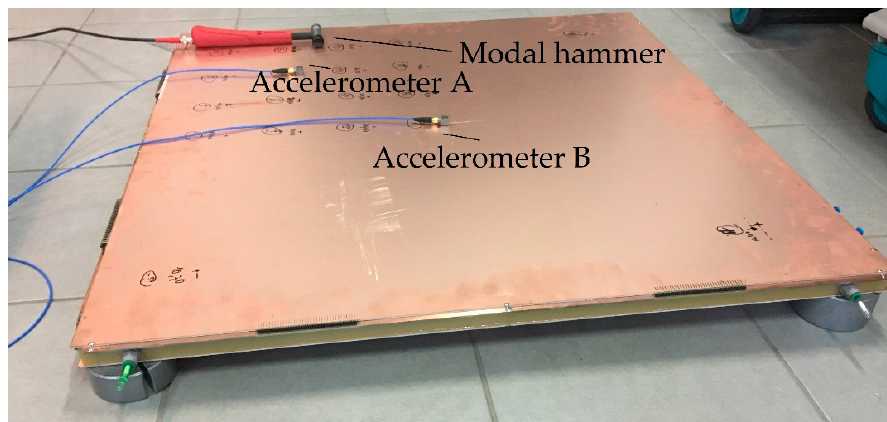
Figure 11. The measurement setup with the modal hammer and the two accelerometers. Polymer foam supports were put under the chamber at the corners.